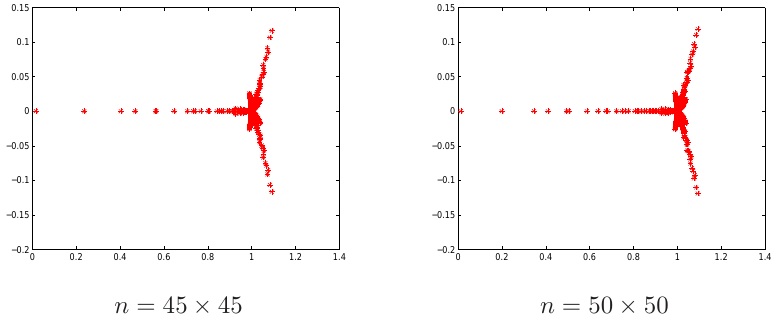
Figure 2. The spectrum of the preconditioned matrix M − 1 A with λ = 19 .